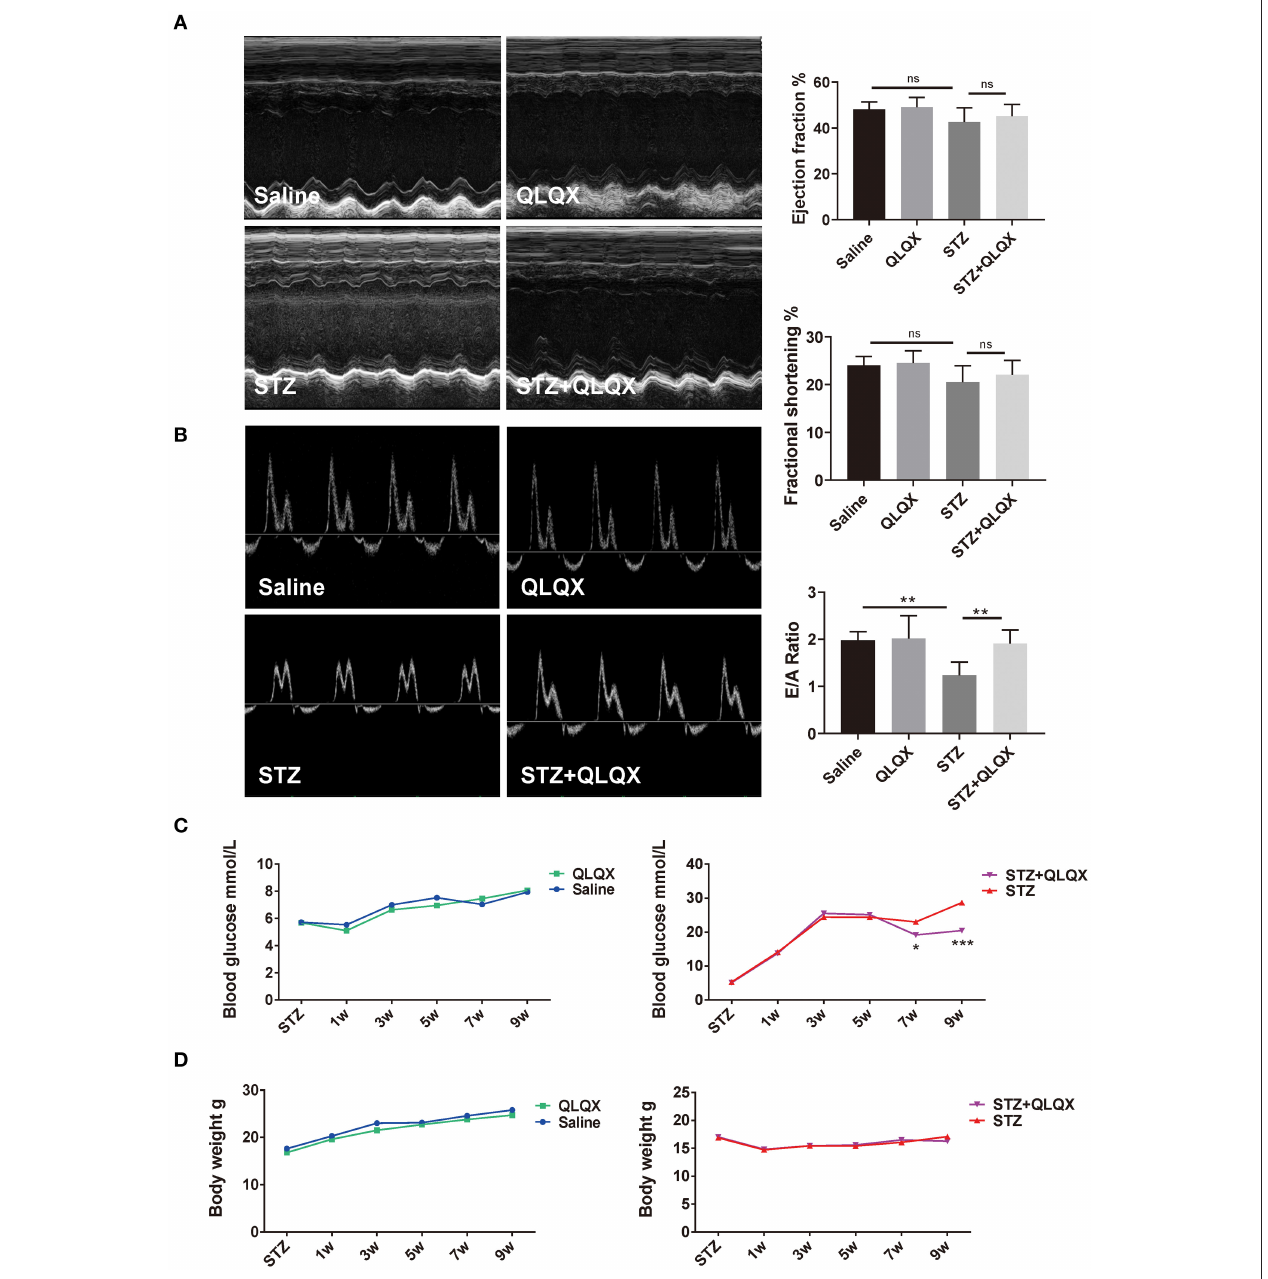
FIGURE 4 | QLQX improved STZ-induced cardiac diastolic dysfunction in vivo . (A) Echocardiography was used to examine cardiac systolic function of mice, indicated in groups ( n = 7, 7, 8, and 7). (B) Cardiac diastolic function of mice was evaluated using echocardiography, indicated in groups ( n = 7, 7, 8, and 7). (C,D) Blood glucose supervision and body weight were recorded after STZ injection and QLQX treatment (saline group n = 9 and QLQX group n = 10; at 7 weeks, STZ group n = 13 and STZ + QLQX group n = 12; at 9 weeks, STZ group n = 12 and STZ + QLQX group n = 11). * p < 0.05; ** p < 0.01; *** p < 0.001; vs. respective